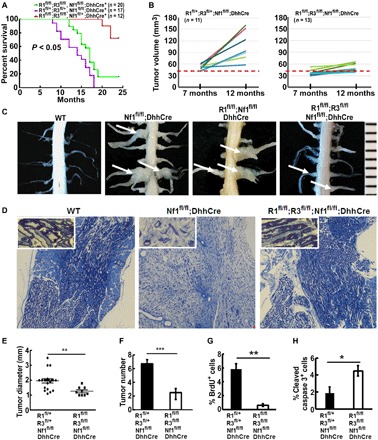
Dual deletion of Runx1/3 prolongs survival time and decreases tumor number and size in the Nf1fl/fl;DhhCre neurofibroma mouse.(A) Kaplan-Meier survival curve. Purple, Runx1fll+;Runx3 fl/+;Nf1fllfl;DhhCre; green, Runx1fl/fl;Runx3fl/fl;Nf1fl/fl;DhhCre; red, Runx1fl/fl;Runx3fl/fl;Nf1fl+;DhhCre. (B) Each mouse volume at 7 and 12 months in controls (Runx1fll+;Runx3 fl/+;Nf1fllfl;DhhCre mice) (left) and Runx1fl/fl;Runx3fl/fl;Nf1fl/fl;DhhCre mice (right). Dashed lines indicate all the control mice volume >40 mm3 at 7 months, while the double-knockout mice volume varied. Mouse tumor volume statistical analysis: Mixed model analysis. Mixed-effects analysis of tumor volume showed P < 0.001 between Runx1fll+;Runx3 fl/+;Nf1fllfl;DhhCre mice and Runx1fl/fl;Runx3fl/fl;Nf1fl/fl;DhhCre mice at 7 and 12 months, respectively. (C) Representative gross dissections of thoracic paraspinal neurofibromas and nerve roots in 12 months of age-matched WT (left), Nf1fl/fl;DhhCre mice (second from the left), Runx1fl/fl;Nf1fl/fl;DhhCre mice (third from the left), and Runx1fl/fl;Runx3fl/fl;Nf1fl/fl;DhhCre mice (right). White arrows point to tumors. Ruler showed 1-mm markings. (Photo credit: Ashley Hall and Jianqiang Wu). (D) Representative photographs of toluidine blue–stained semithin sections from age-matched WT (left), Nf1fl/fl;DhhCre (middle), and Runx1fl/fl;Runx3fl/fl;Nf1fl/fl;DhhCre (right) mouse DRGs. Top-left corner insertions are high magnification of imagings to each corresponding genotype. (E) Tumor diameter in the Runx1fll+;Runx3 fl/+;Nf1fllfl;DhhCre mice (circles; n = 3 mice with 20 tumors) and Runx1fl/fl;Runx3fl/fl;Nf1fl/fl;DhhCre mice (squares; n = 4 mice with nine tumors) at 12 months. (F) Average tumor number per mouse at 12 months in the Runx1fll+;Runx3fl/+;Nf1fllfl;DhhCre mice (black bar; n = 3) and Runx1fl/fl;Runx3fl/fl;Nf1fl/fl;DhhCre mice (white bar; n = 4). (G) Cell proliferation shown as percentage of BrdU+ cells in Runx1fll+;Runx3fl/+;Nf1fllfl;DhhCre mice (black bar; n = 5) and Runx1fl/fl;Runx3fl/fl;Nf1fl/fl;DhhCre mice (white bar; n = 5). (H) Cell death shown as percentage of CC3+ cells in Runx1fll+;Runx3fl/+;Nf1fllfl;DhhCre mice (black bar; n = 5) and Runx1fl/fl;Runx3fl/fl;Nf1fl/fl;DhhCre mice (white bar; n = 5). (D to G) Unpaired Student’s t test. *P < 0.05, **P < 0.01, and ***P < 0.001. R1fl/fl;R3fl/fl;Nf1fl/fl;DhhCre = Runx1fl/fl;Runx3fl/fl;Nf1fl/fl;DhhCre.